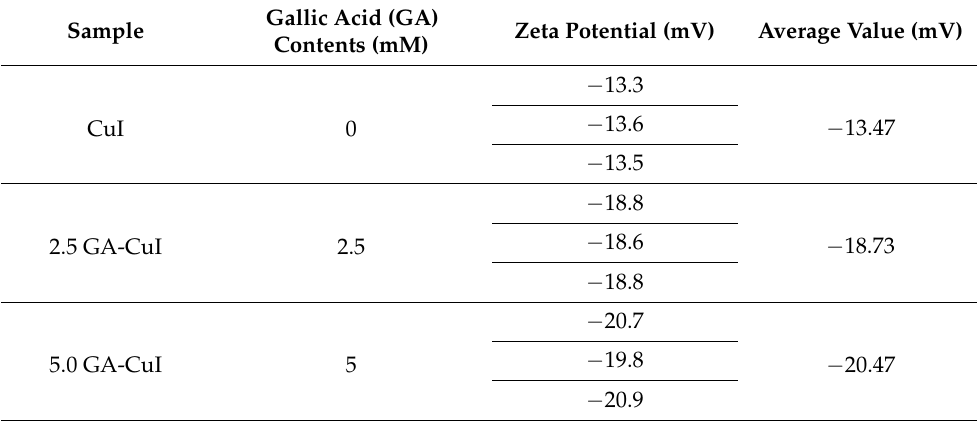
Table 1. Zeta potential of synthesized CuI